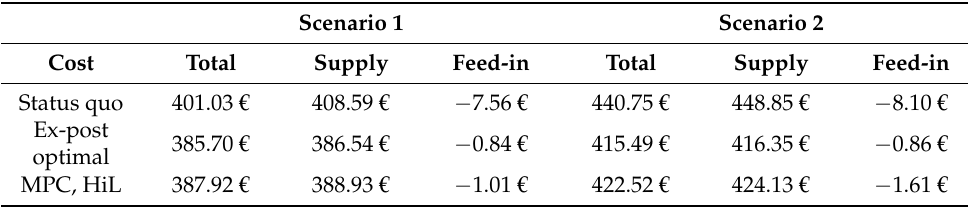
Table 2. Operational cost comparison of simulated